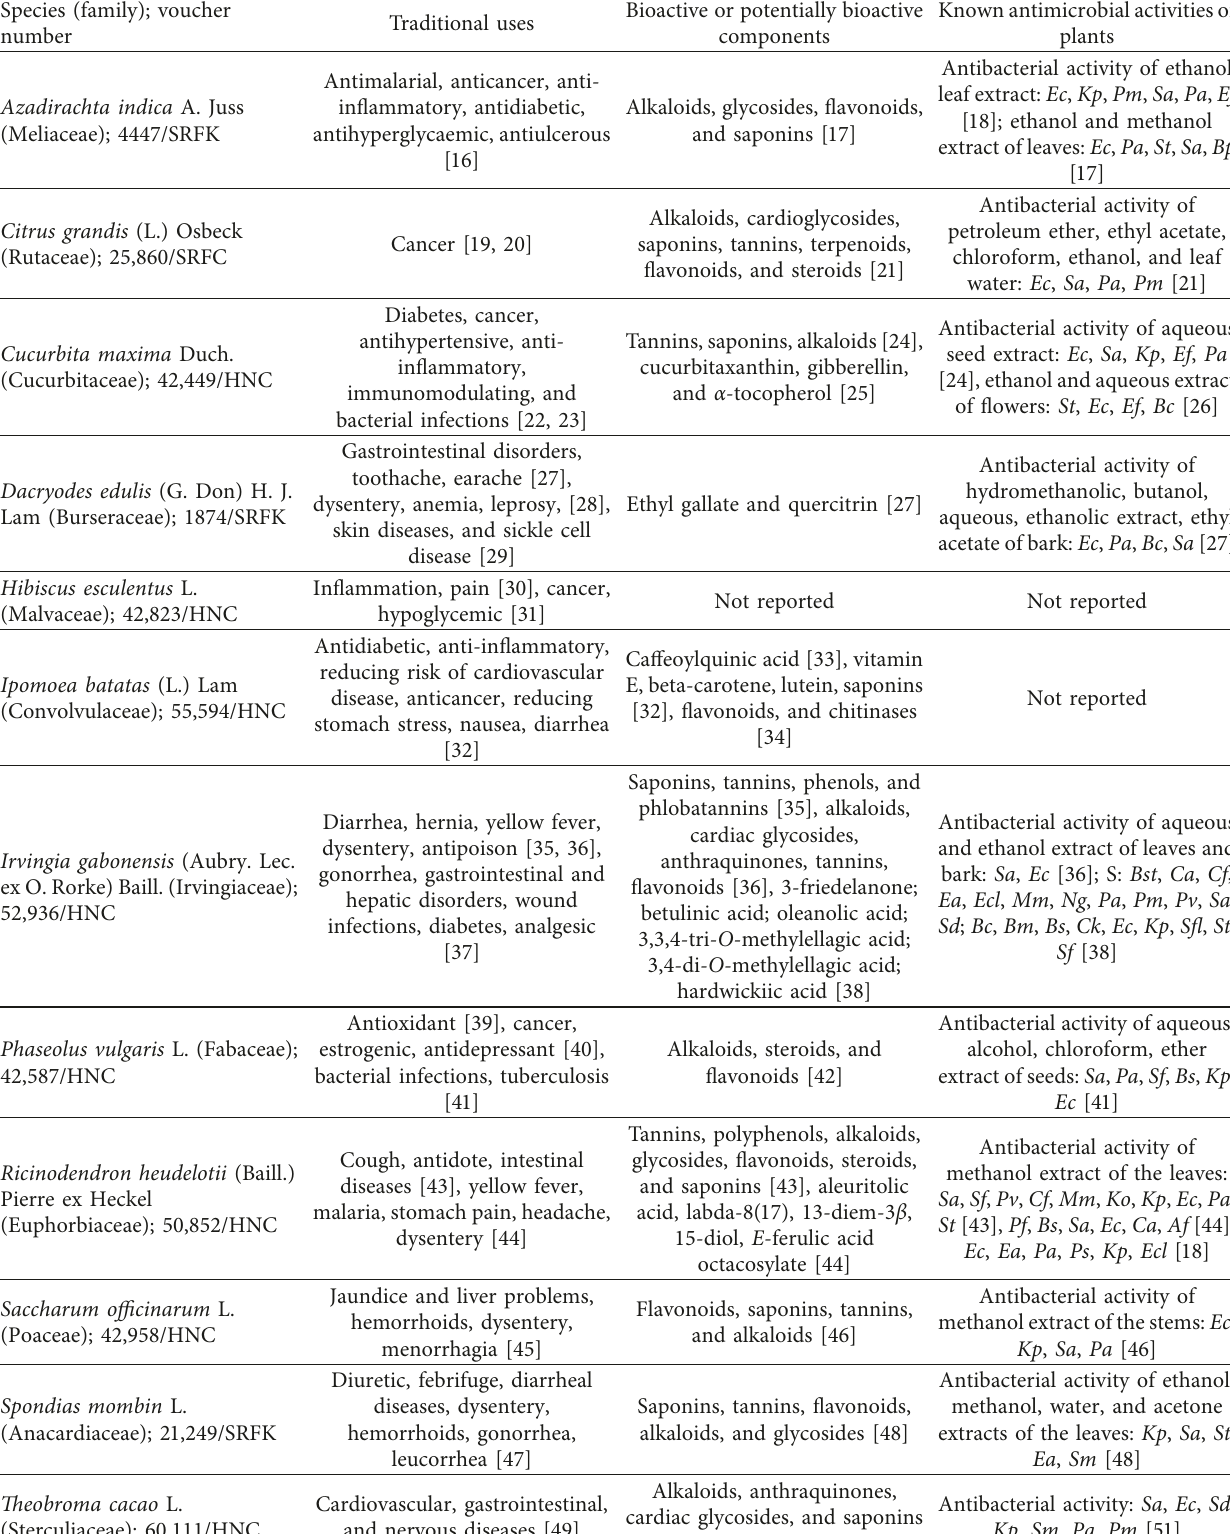
Table 1: Information on the studied